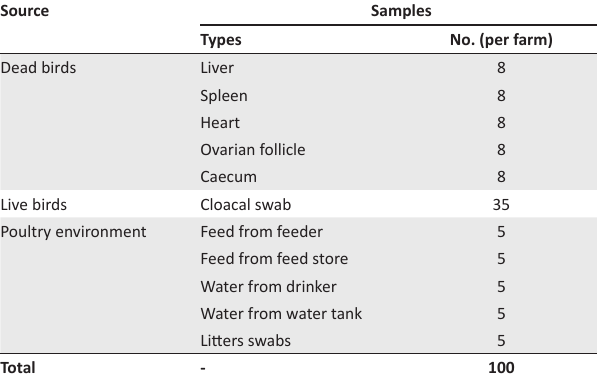
TABLE 1: Types and number of samples. Source